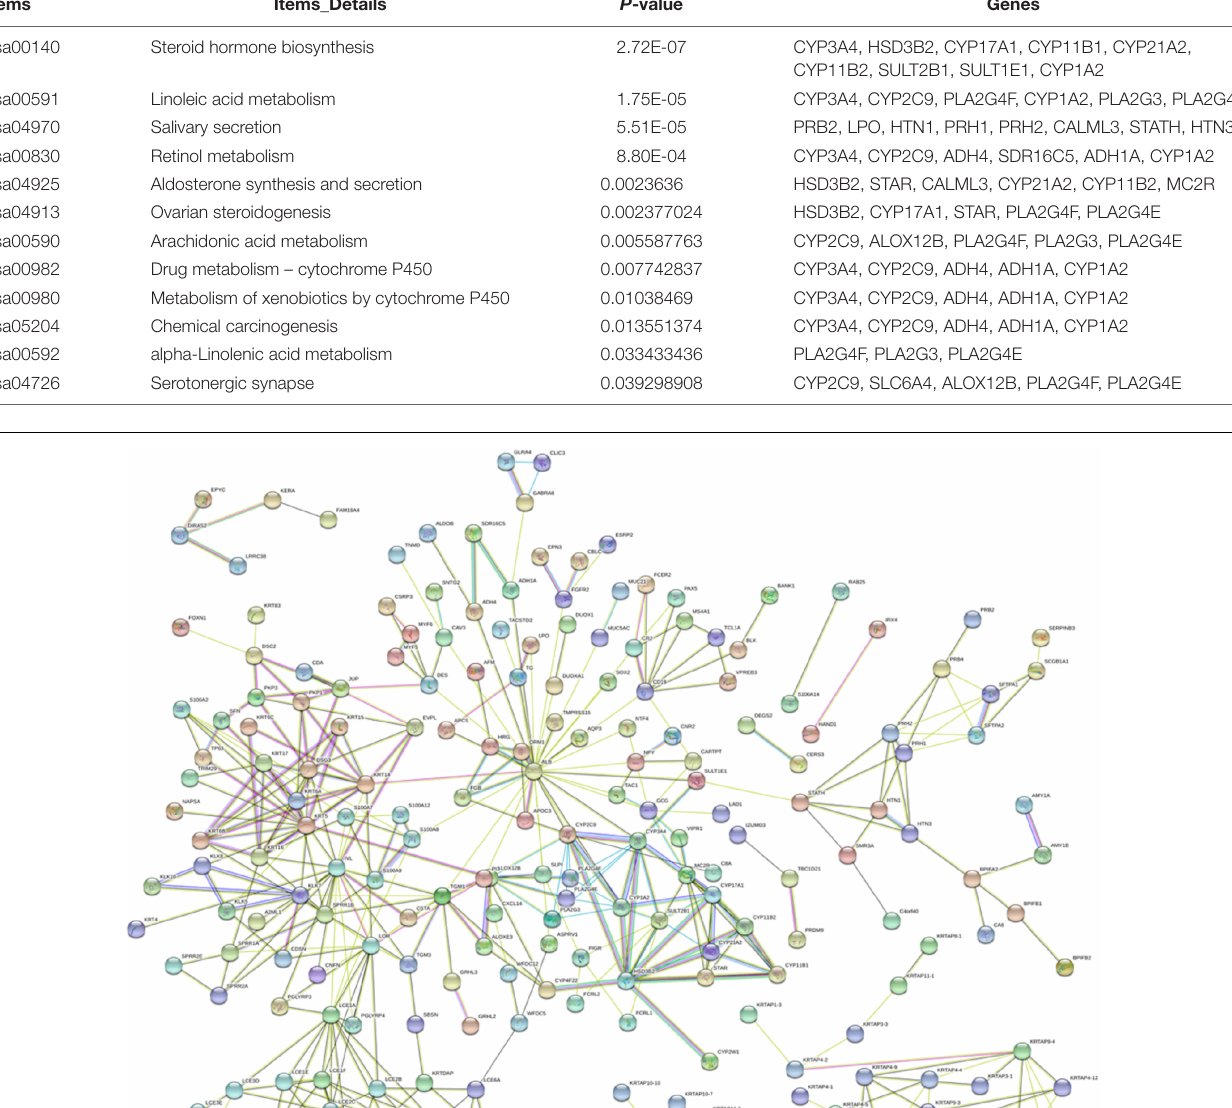
(Liu et al., 2016). Another study identified the MIR31HG lncRNA gene as showing among the greatest expression changes upon BRAF V600E expression. MIR31HG expression inversely correlated with p16INK4A, and its overexpression may represent a frequent driver event of melanoma progression (Montes et al., 2015). Flockhart et al. (2012) identified BRAF- activated non-coding RNA ( BANCR ) by analyzing